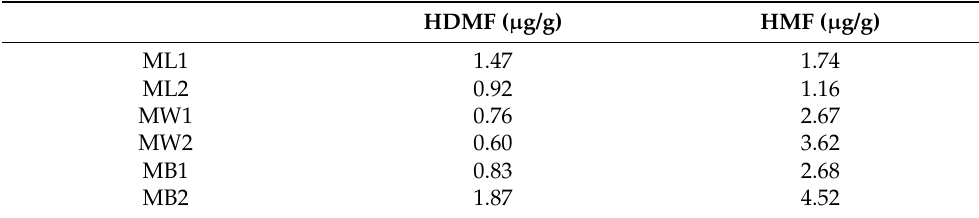
Table 2. Furanone analysis via HPLC, measured in technical duplicates. The moromi was sampled after four months of incubation with lupine seeds as sole substrate (ML), wheat (MW), and buckwheat